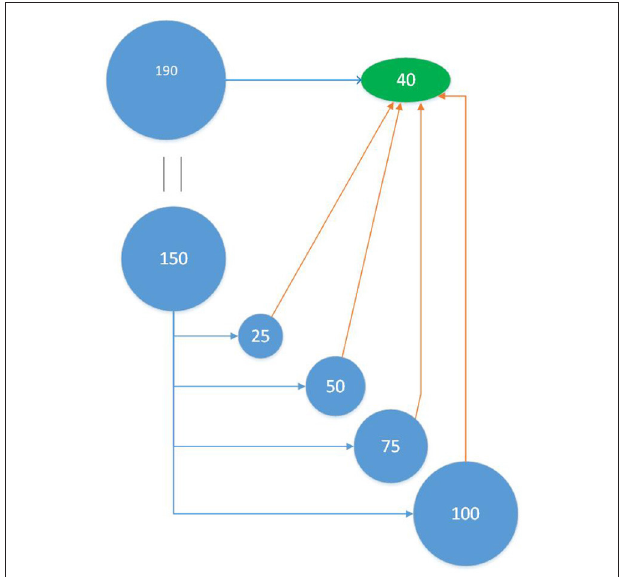
FIGURE 2 | Training-Test (TT) Scheme: Out of the 190 individuals a test set of 40 individuals were randomly selected. The remaining 150 individuals were now candidates for the training set and from this set, 25 individuals were selected and used to train the model that predicts the test set. This was performed 50 times for each training set sampling method. This process was repeated for 50 different test sets. The analysis was performed at varying training set sizes (25, 50, 75, and